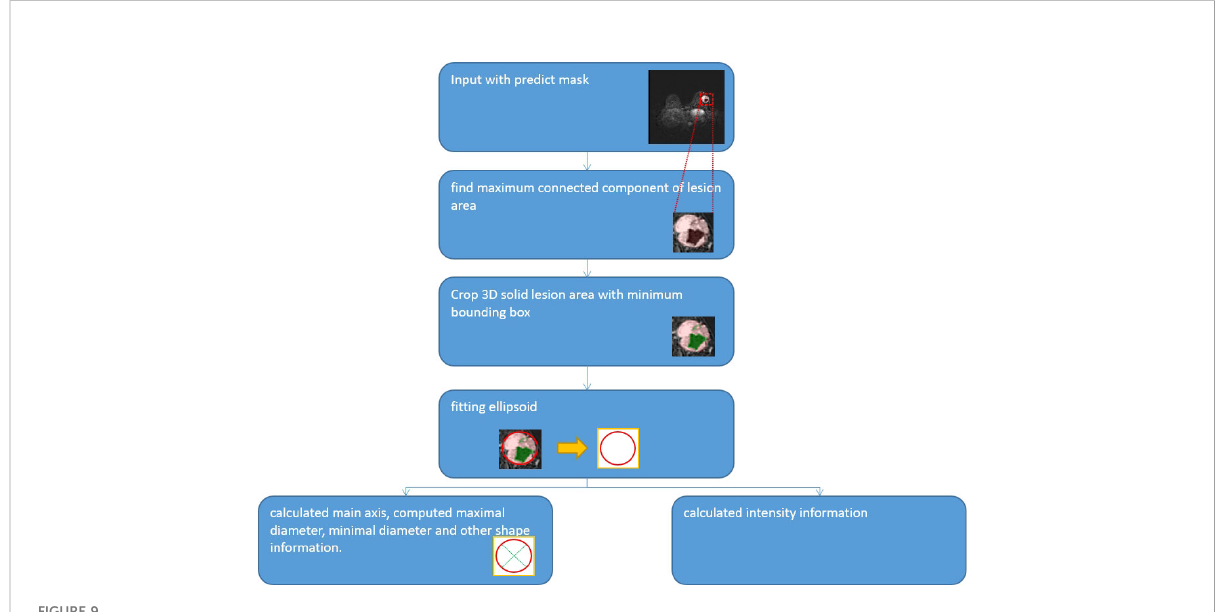
FIGURE 9 Work fl ow of